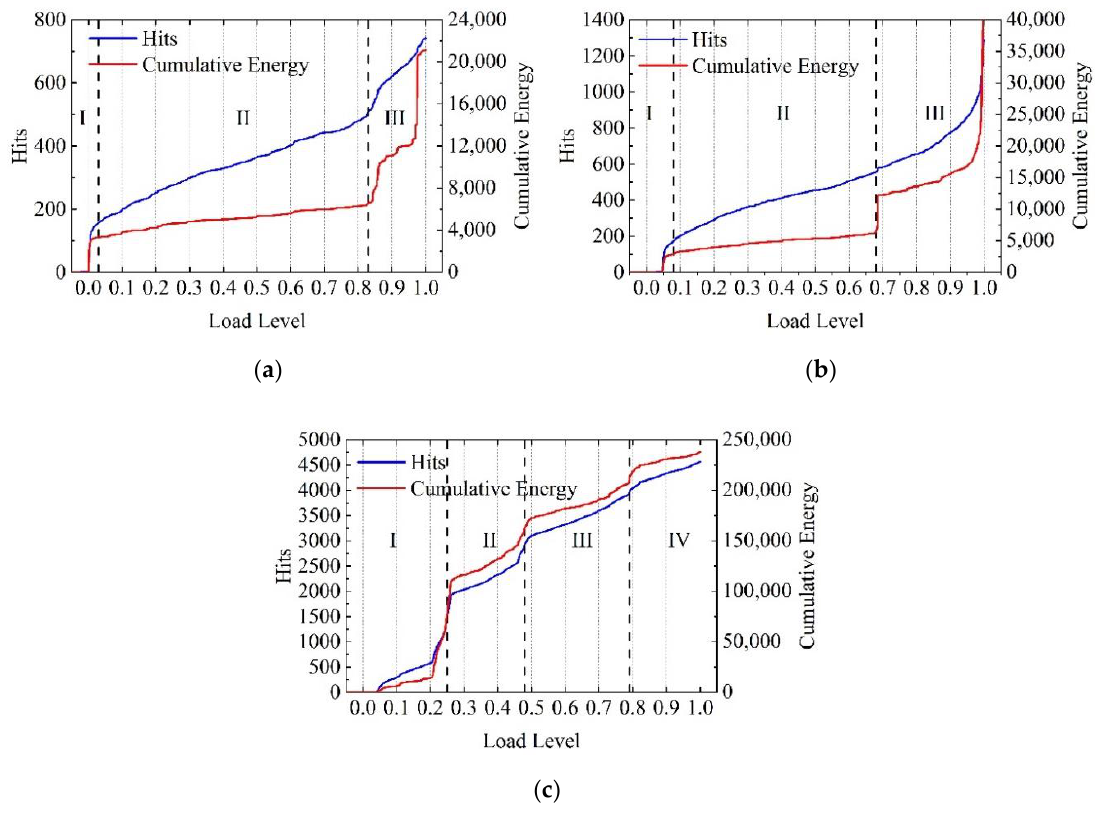
Figure 8. History curves of load level versus cumulative AE features: ( a ) basalt fiber content of 6 kg/m³; ( b ) basalt fiber content of 10 kg/m³; and ( c ) basalt fiber content of 14 kg/m³.